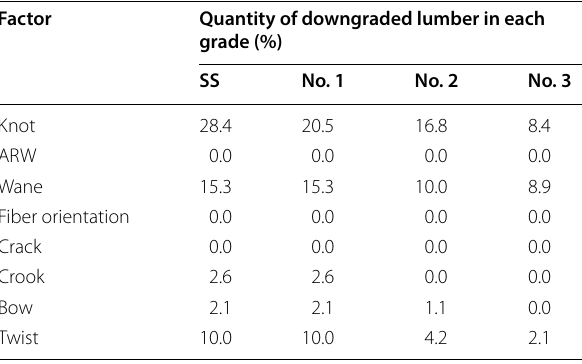
Mean values were calculated from the ratio of the lumber downgraded to total lumber. Total